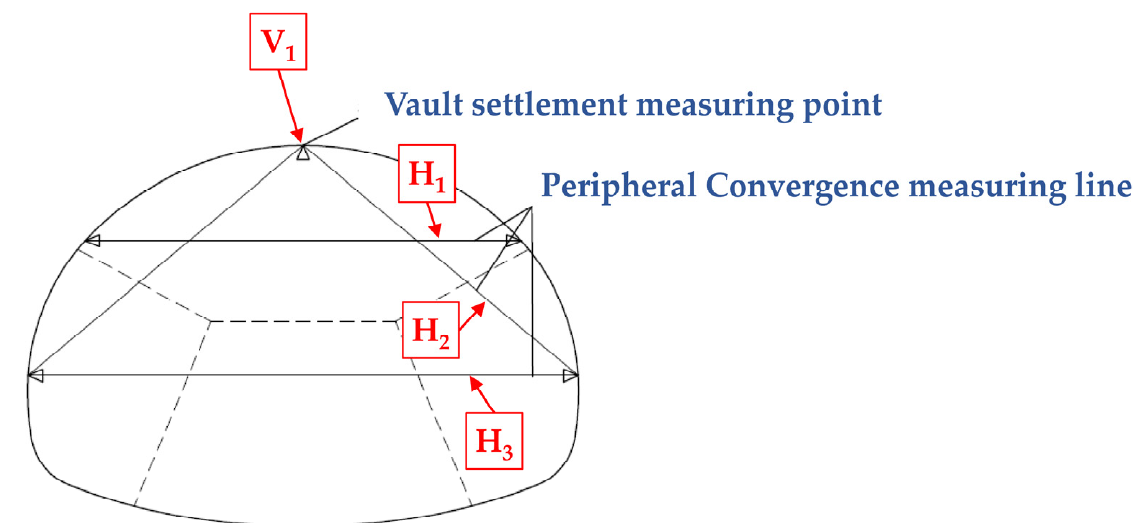
Figure 4. The layout of vault settlement and peripheral convergence measuring points.